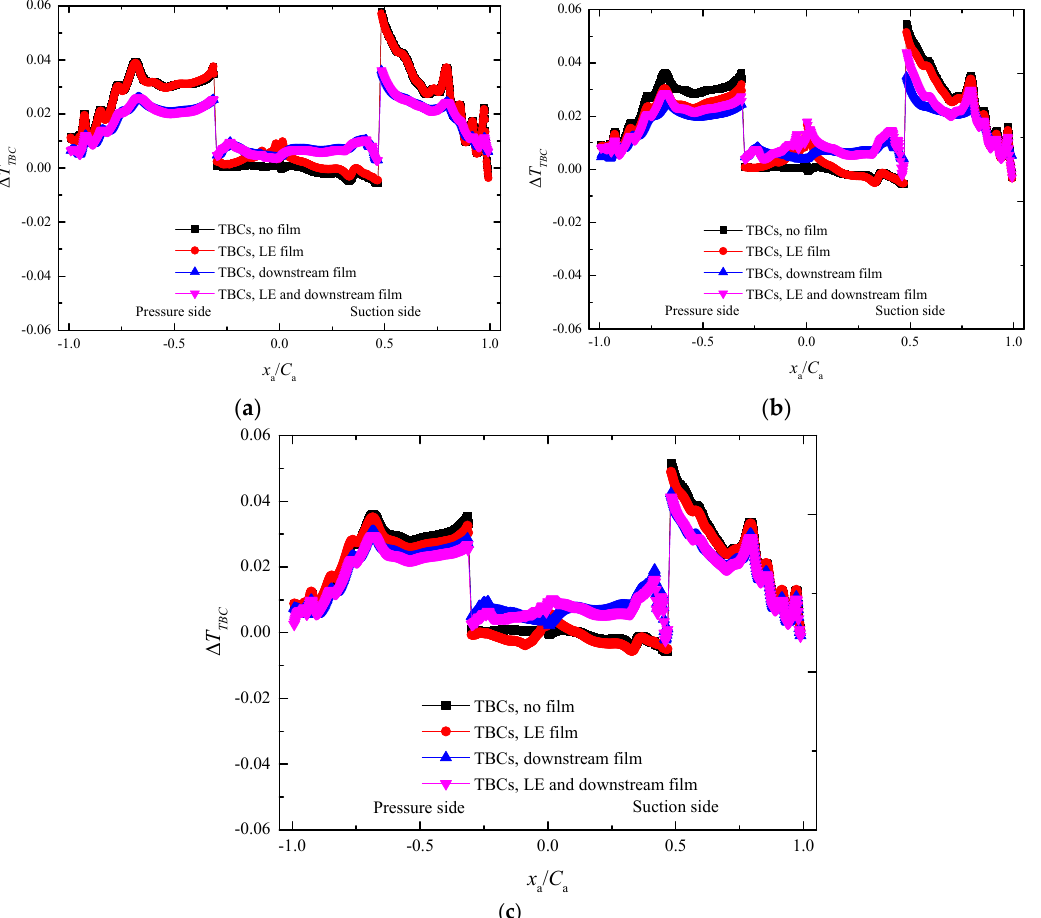
Figure 12. Temperature reduction distribution comparisons for different cases. ( a ) z = −19.3 mm, ( b ) z = 0 mm, ( c ) z = 19.3 mm.